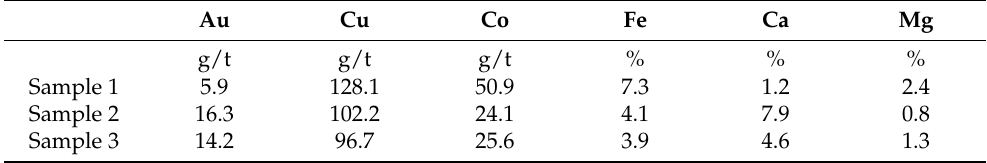
Table 1. Elemental composition of ore samples.